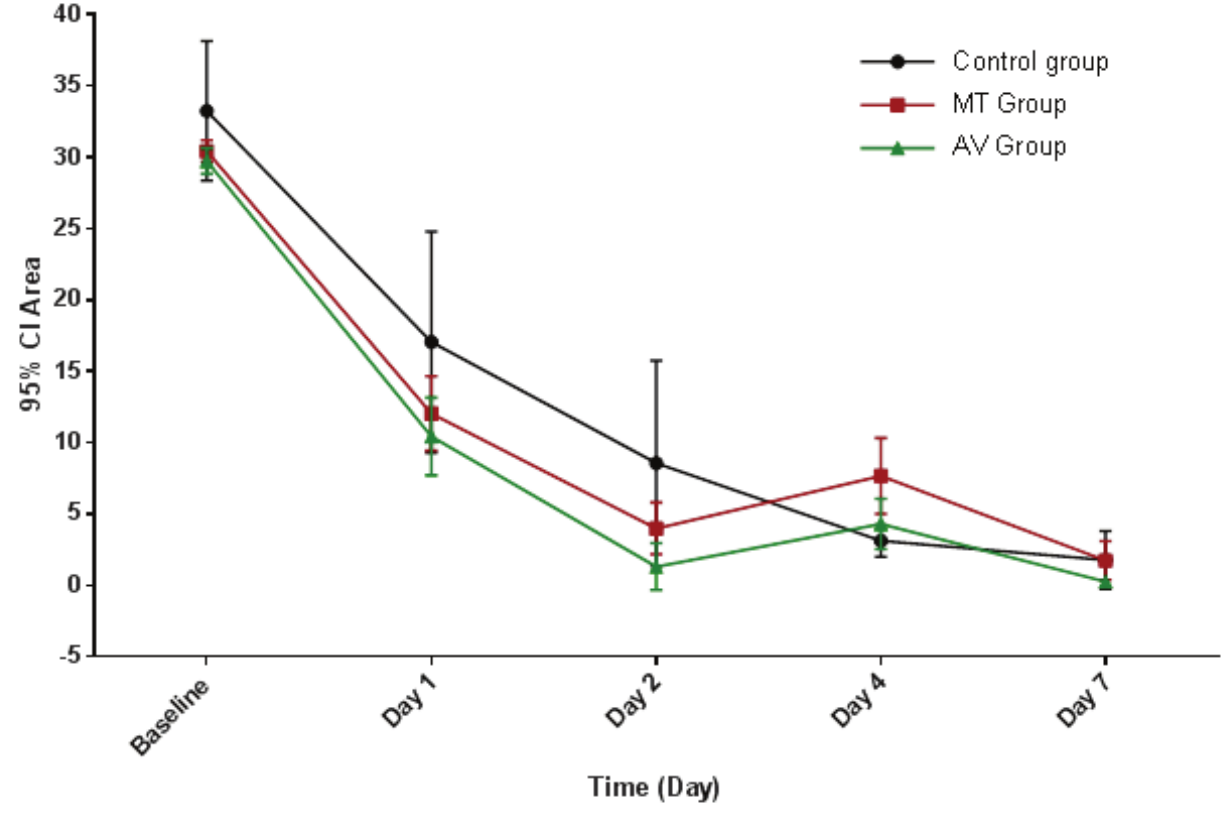
Figure 2. Photographs of fluorescein-stained rabbit corneas following alkaline burn in the AV, MT, and control groups at baseline (day 0) and over the seven-day